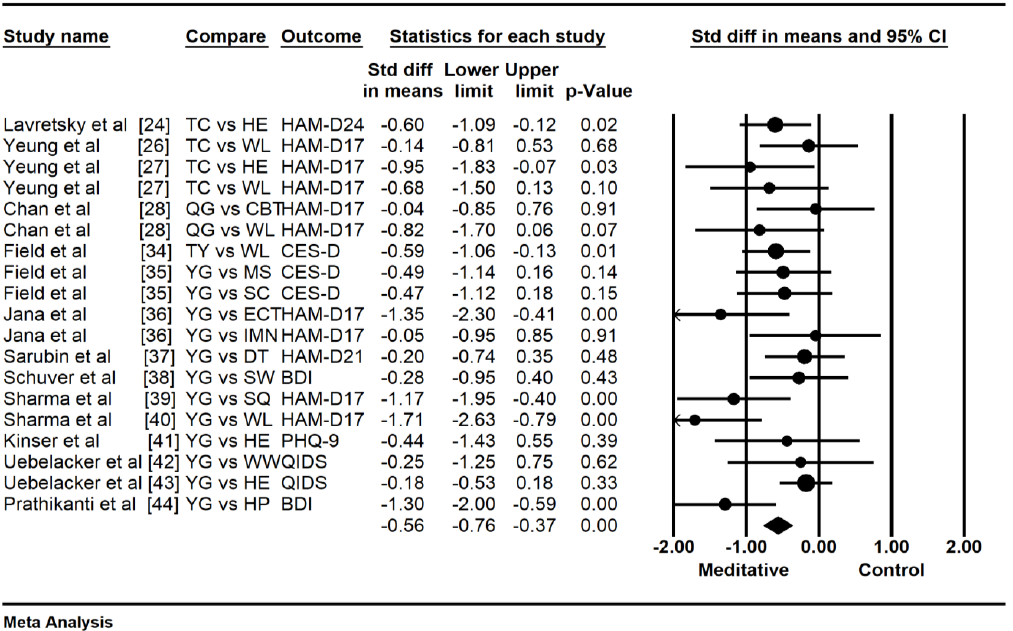
Figure 3. Effects of meditative movements on depression.